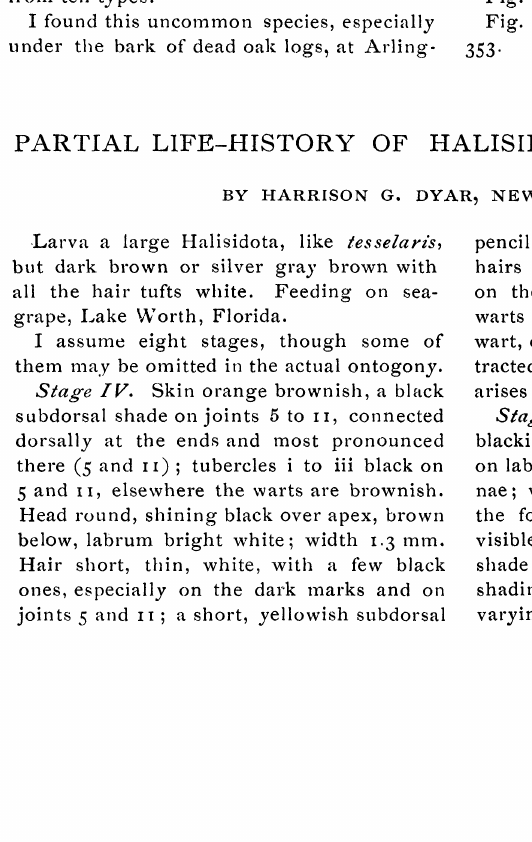
Fig. 3. hind toot, 472 Fig. 4. Smyntkurus socialis, modified male antenna, x 171. Fig. 5" Smynlkurus benitus, terminal an- tennal segment, x I6. Fig. 6. Smyntkurus amlcus, fore foot, x Fig. 8. hind foot, x